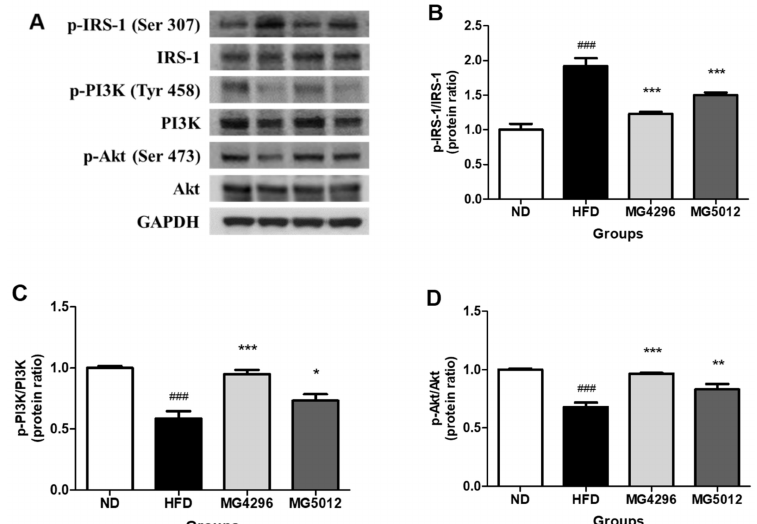
Figure 6. Effects of MG4296 and MG5012 on the IRS-1/PI3K/Akt protein expression in liver tissue of HFD-induced T2DM mice. ( A ) Representative western blot, ( B ) p-IRS-1/IRS-1, ( C ) p-PI3K/PI3K, and ( D ) p-Akt/Akt. Data are presented as mean ± SD ( n = 3). ### p < 0.001 vs. ND group. * p < 0.05, ** p < 0.01, *** p < 0.001 vs. HFD group. ND; normal diet, HFD; high-fat